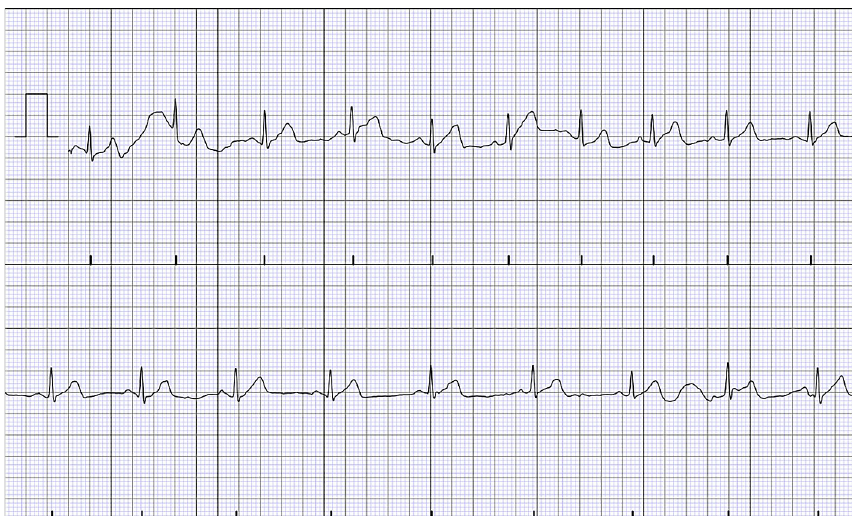
Figure 2. The example of 2-D ECG in a PDF